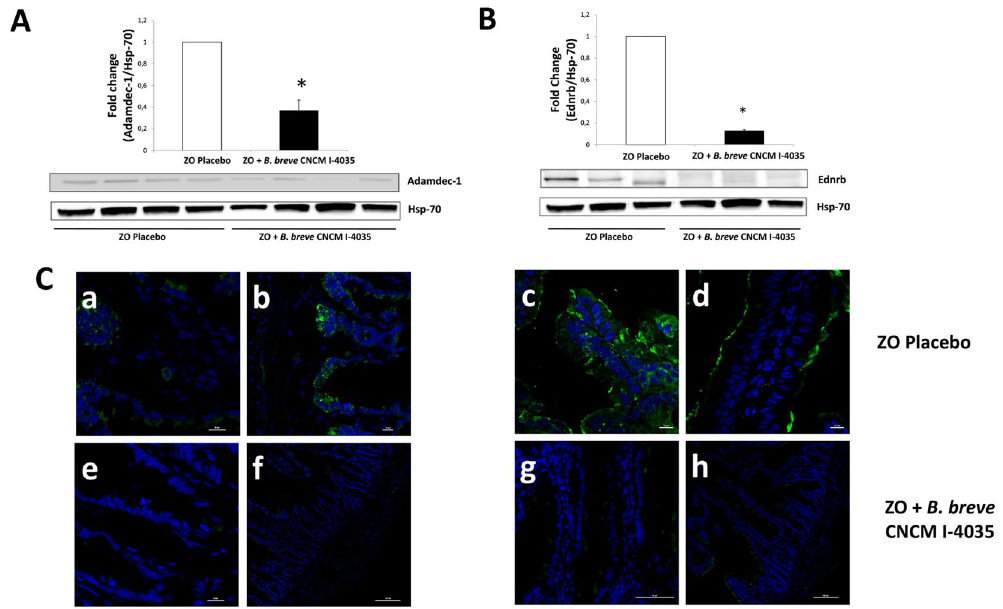
Figure 4. Immunofluorescence and western blot analysis of Adamdec1 and Ednrb proteins from Zucker- Lepr fa / fa rats fed the placebo compared with Zucker-Lepr fa / fa rats fed B . breve CNCM I-4035. In panels A and B, top graphs include 6–8 rats per group, and the lower parts show a representative crop blot. Hsp-70 was used as a loading control. * P < 0.05. In panel C, micrographs a,b (ZO placebo) and e,f (ZO + B . breve CNCM I-4035) show results for Adamdec1, and micrographs c,d (ZO placebo) and g,h (ZO + B . breve CNCM I-4036) show results for Ednrb. The green color corresponds to Alexa Fluor 488 dye. ZO, Zucker-Lepr fa / fa